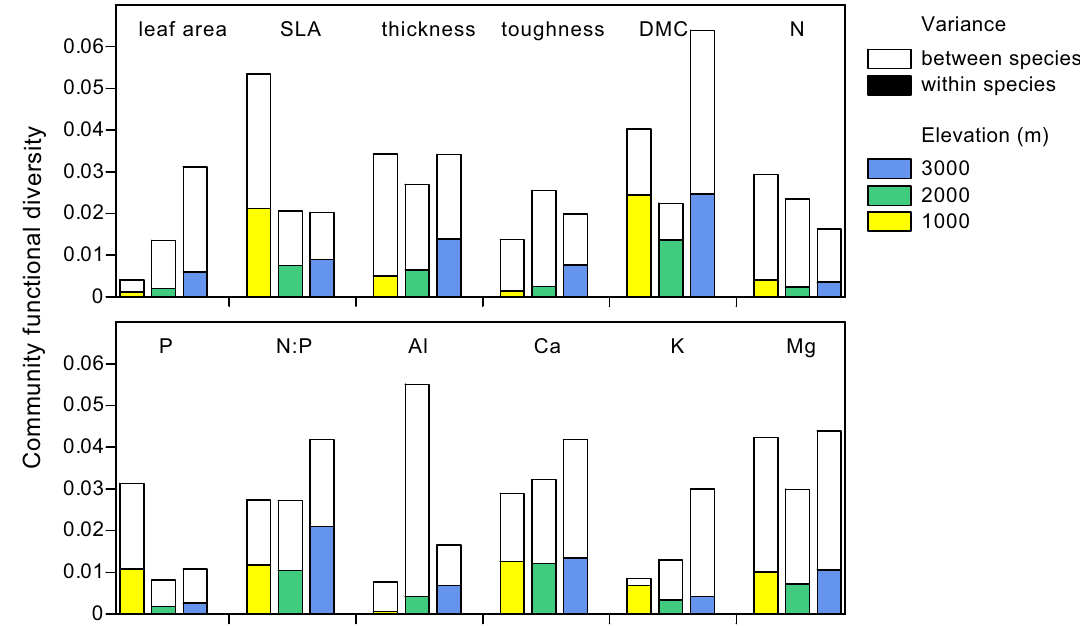
Figure 3. Partitioning of community functional diversity into between- and within-species functional diversity for the 12 studied leaf traits at the three elevation levels.